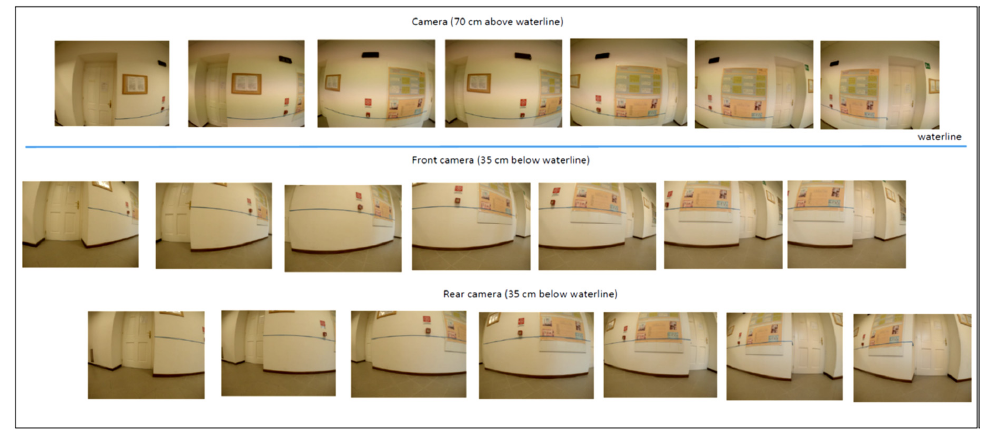
Figure 4. Time-lapse images collected in the laboratory corridor. The first line corresponds to the camera above the waterline, while the second and third lines collected images at lower elevations that correspond to the submerged setting. As aforementioned, the latter cameras are slightly convergent.